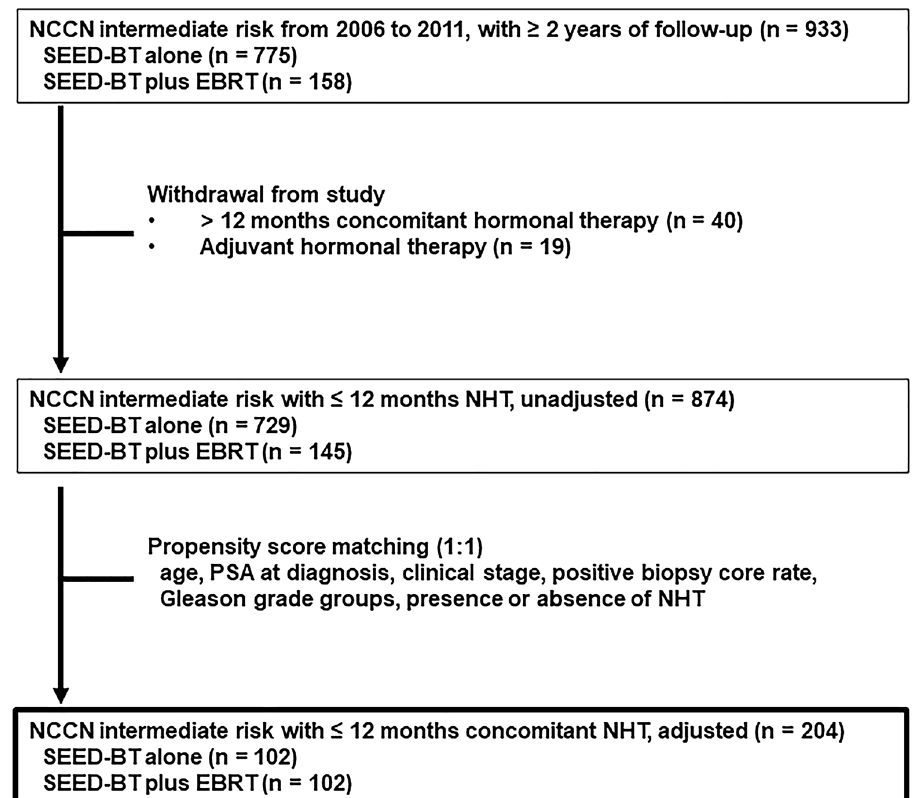
Figure 1. Patient selection for the study. EBRT = external-beam radiotherapy; NCCN = U.S. National Comprehensive Cancer Network guidelines (2019, version 4); NHT = neoadjuvant hormonal therapy; PSA = prostate-specific antigen; SEED-BT = seed